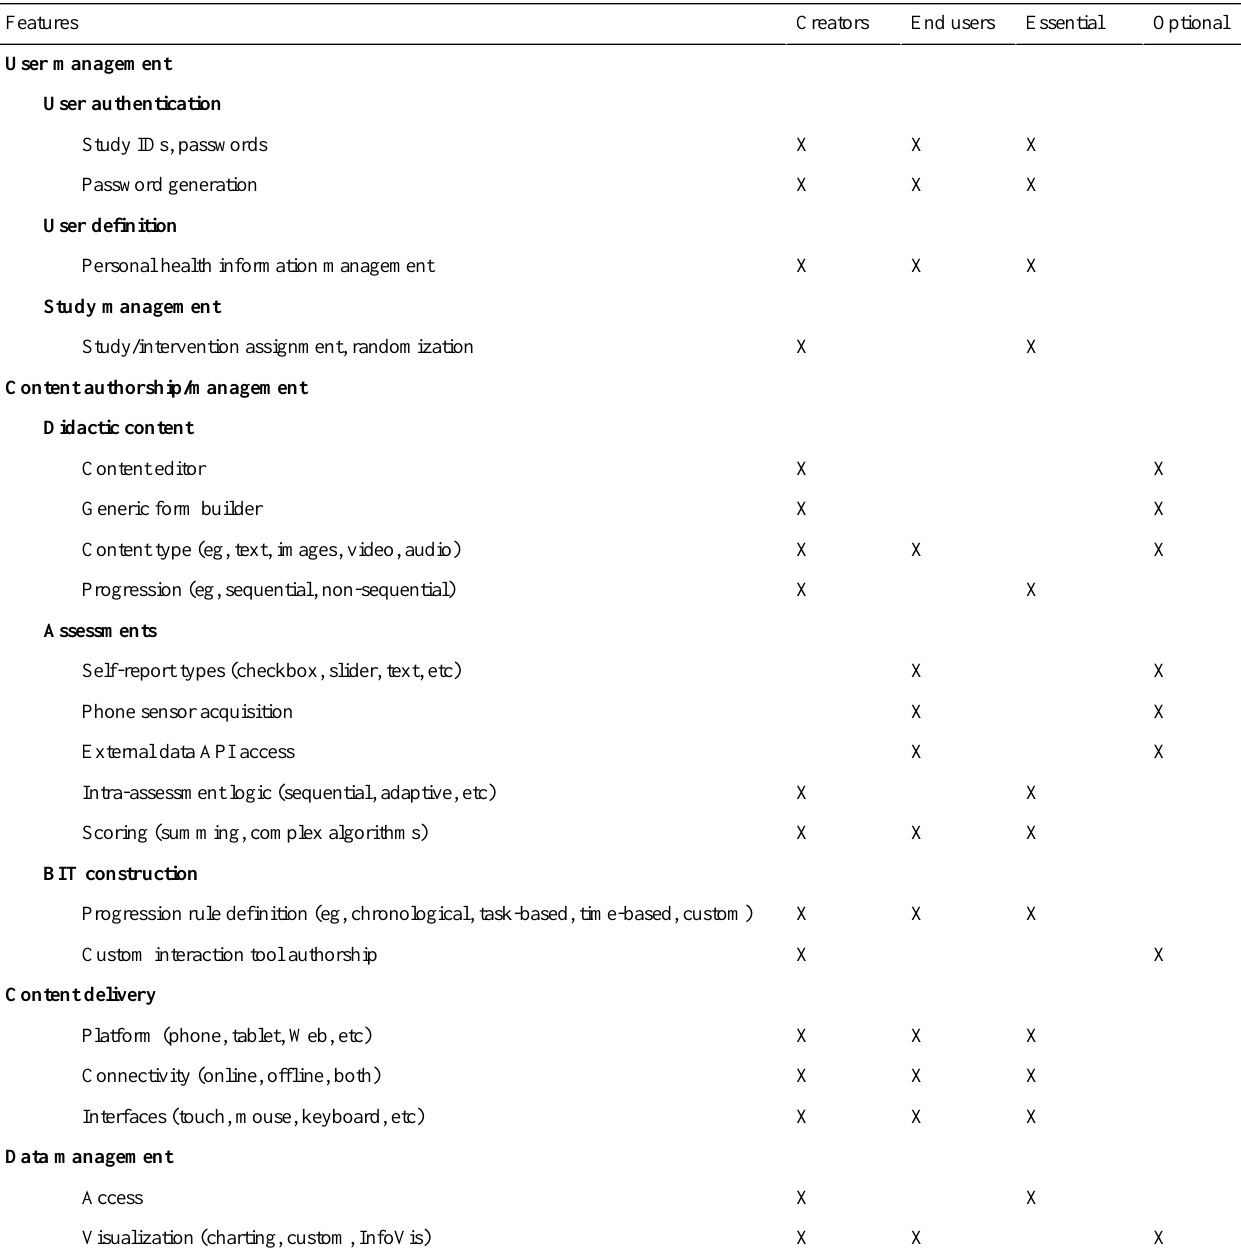
Table 1. Technical features of